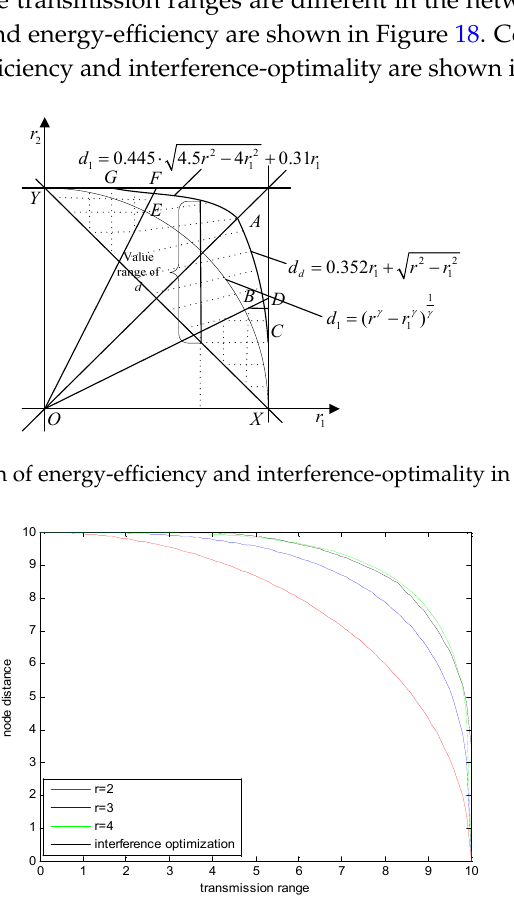
Figure 19. The boundary of energy-efficiency and interference-optimality in heterogeneous networks.